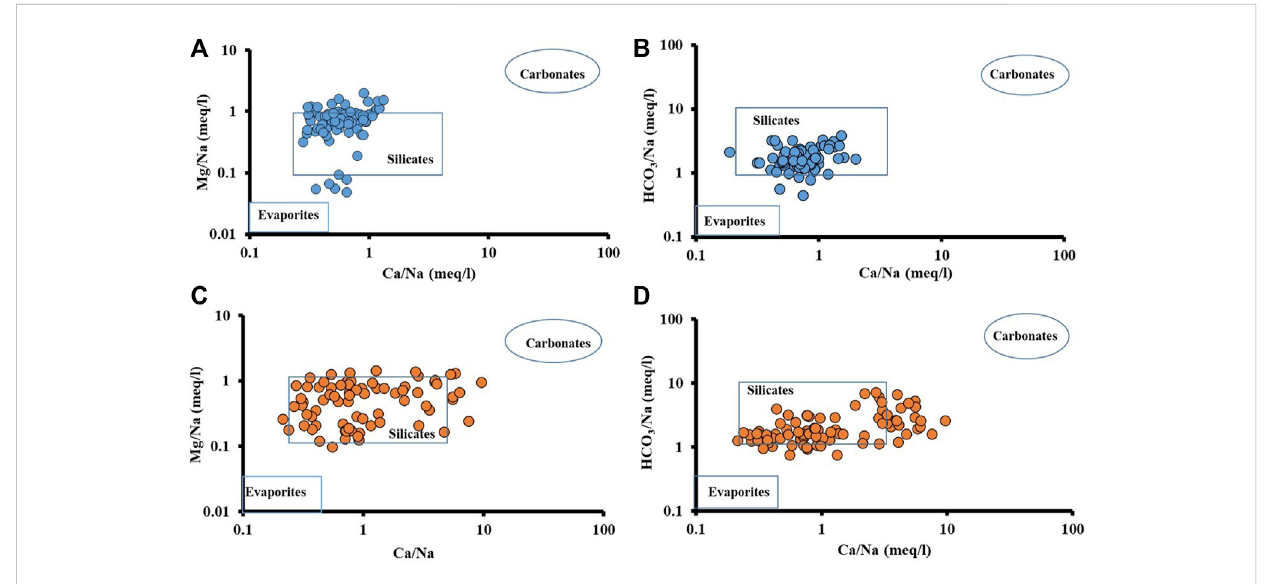
FIGURE 11 Weathering process in (A, B) river water and (C, D)